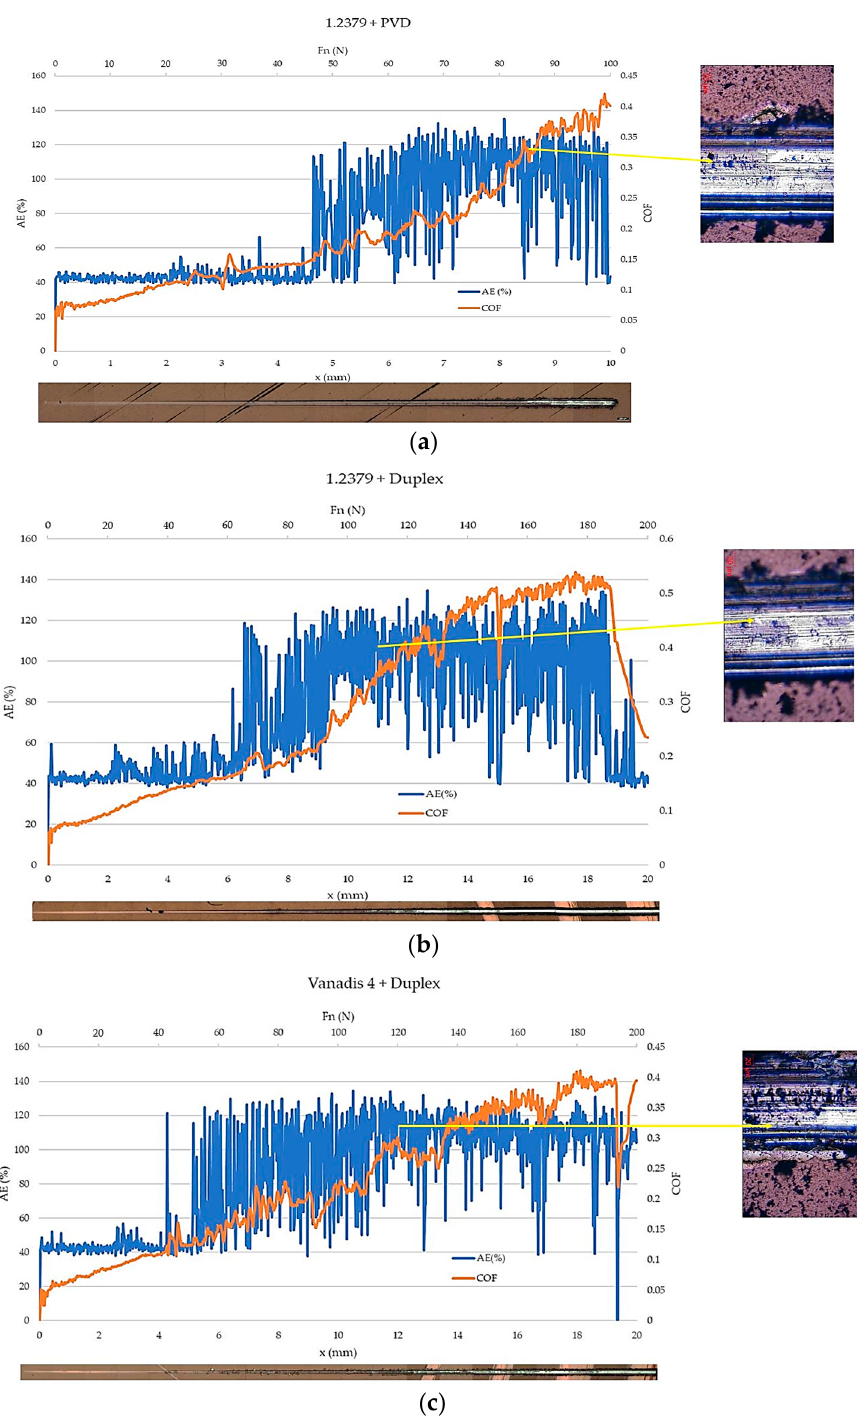
Figure 5. Scratch test results. Evolution of the coefficient of friction (orange plot) and acoustic emis- sion (blue plot) vs. the indenter displacement and the normal force: 1.2379 + PVD sample ( a ), 1.2379 + Duplex sample ( b ), and Vanadis 4 + Duplex sample ( c ).